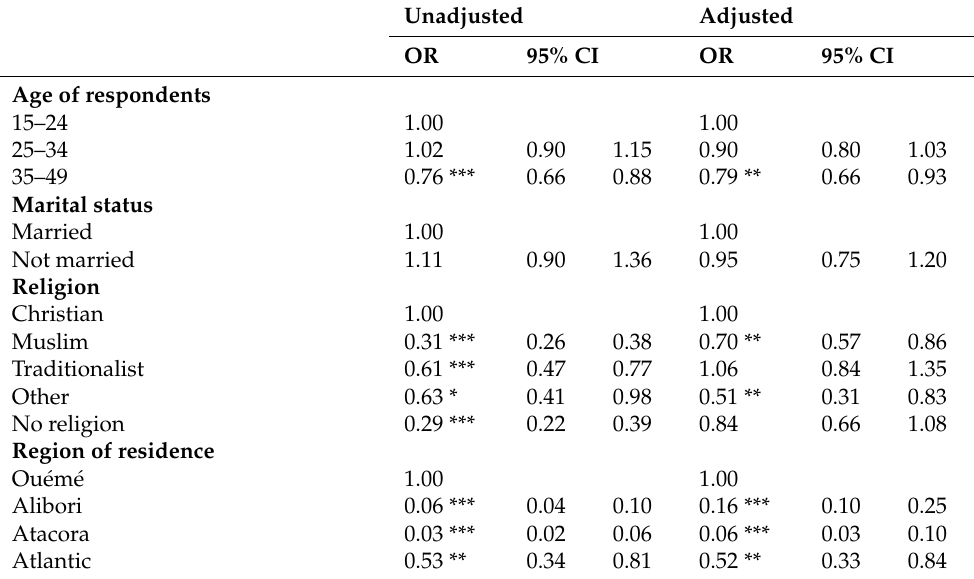
Table 2. Logistic regression predicting the use of deworming medication in